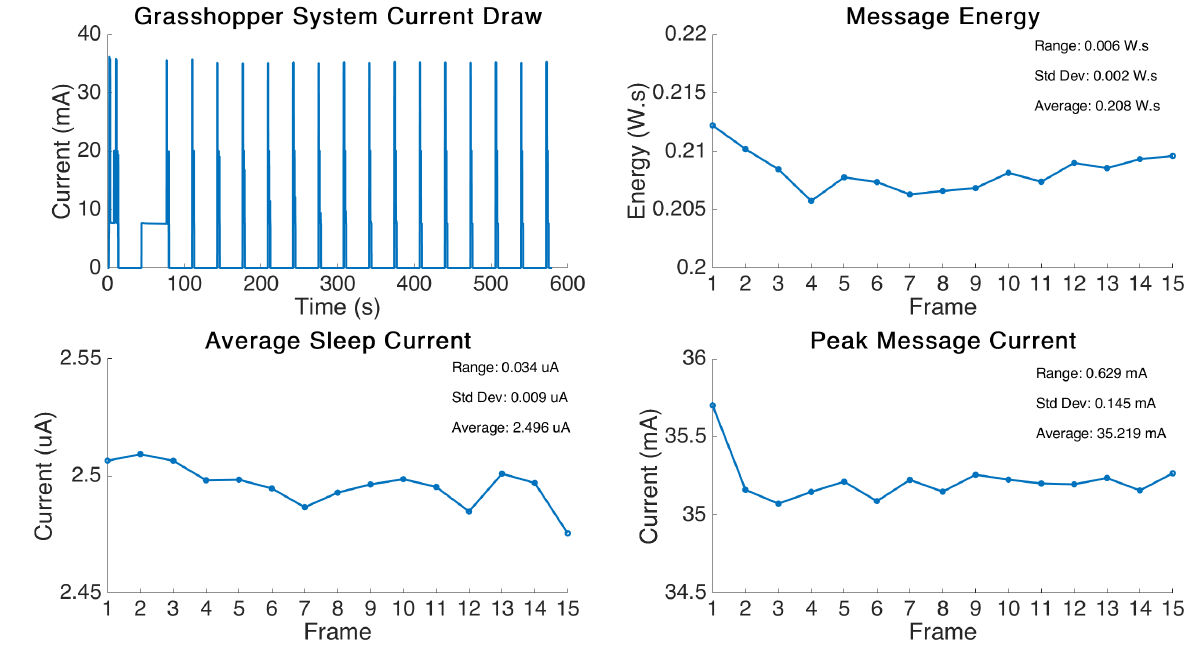
Figure 4. Grasshopper board multiple frame power analysis t int = 30